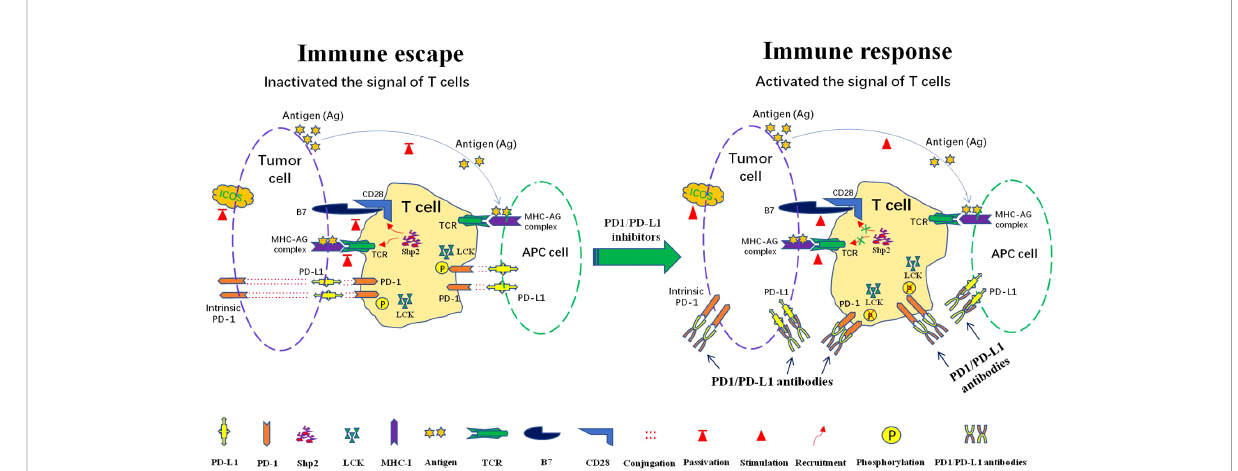
FIGURE 1 Mechanisms of the response to anti-PD1/PD-L1 immunotherapy: PD-L1 is expressed in tumor cells and antigen presenting cells (APCs). PD-1 is mainly expressed in T cells, some tumor cells also express intrinsic PD-1. Immune escape occur after interaction of PD-1 and PD-L1. PD-1 can be phosphorylated by LCK to recruit tyrosine phosphatase Shp2, consequently inactivating CD28 and T cell receptor (TCR) function and signaling pathway, thus attenuating the activation signal of T cells and causing immune escape. Lck kinase activity is required to maintain PD-1/ Shp2-mediated inhibitory signaling. The intervene of PD-1/PD-L1 immunocheckpoint inhibitors can effectively block the interaction between PD-L1 and PD-1, which in turn blocks the recruitment of SHP-2 and reactivates T cells signal for immune